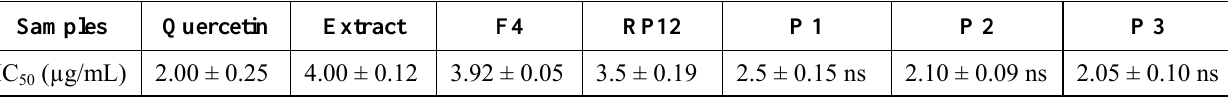
Table 4. DPPH activity of the methanolic extract of C. perpulchrum and of the fractions. Samples Quercetin Extract